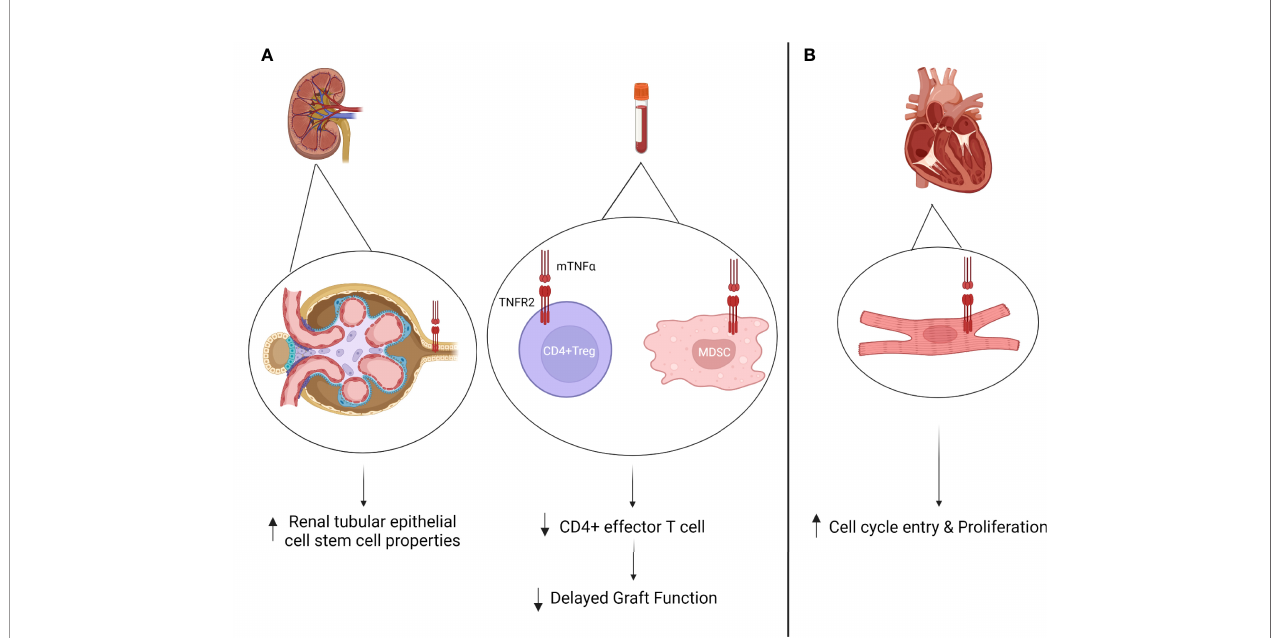
FIGURE 3 | (A) TNFR2 expression in kidney transplantation. Increased TNFR2 expression on tubular epithelial cells during acute rejection episode has been associated with renal tubular regeneration (108). Circulating pre-transplant TNFR2 expression on CD4+Tregs has been associated with decreased delayed graft function (DGF) rates (109). Circulating post-transplant MDSCs has been associated with increased CD4+Treg frequency (105). (B) Increased TNFR2 expression on cardiomyocyte post-transplantation has been associated with increased cell cycle entry and proliferation during acute rejection episodes